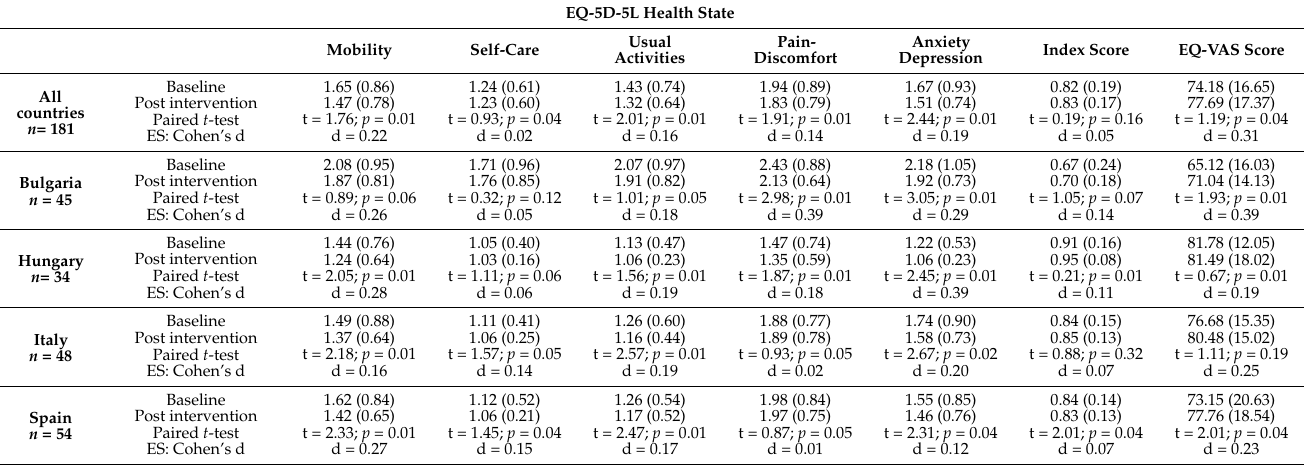
Table 4. EQ-5D-5L health state. Effects of the STRENOLD Program by